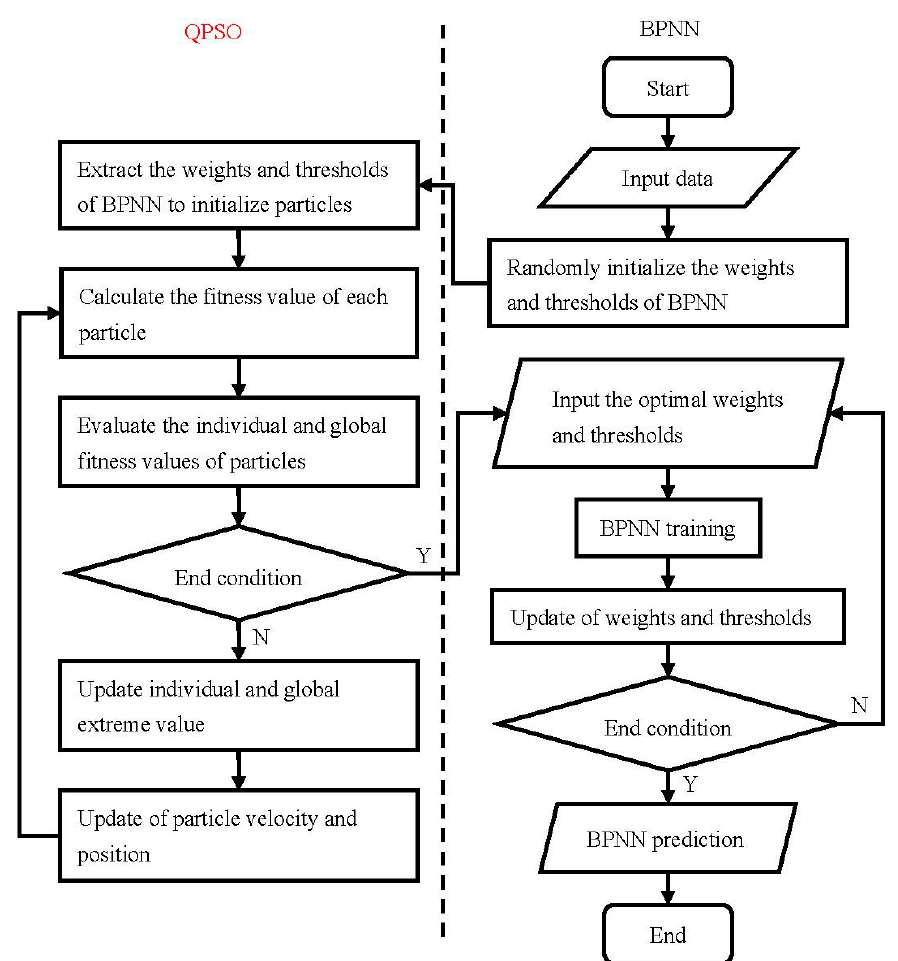
Figure 5. The flow chart of the back-propagation neural network and quantum-behaved particle swarm optimization algorithm (BPNN-QPSO).